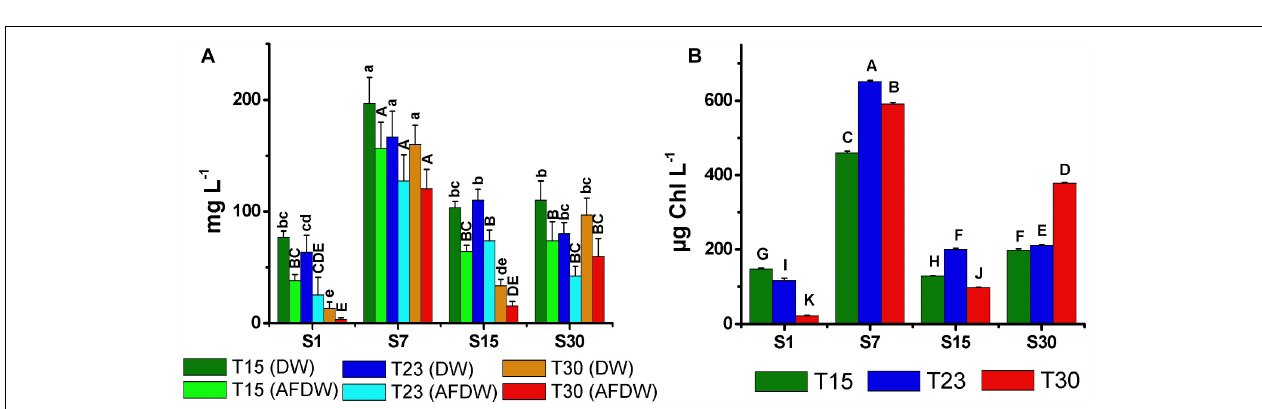
FIGURE 5 | Percentage of akinete per cell ( ± SD; n = 3) of N. spumigena (NODSPU1) observed along the time in the factorial experiment, which analyzed the influence of temperature (T15, T23, T30 ◦ C) and salinity S1 (A) , S7 (B) , S15 (C) , and S30 (D) . Significant difference between treatments is indicated by letters (ANOVA, Tukey’s p < 0.05).